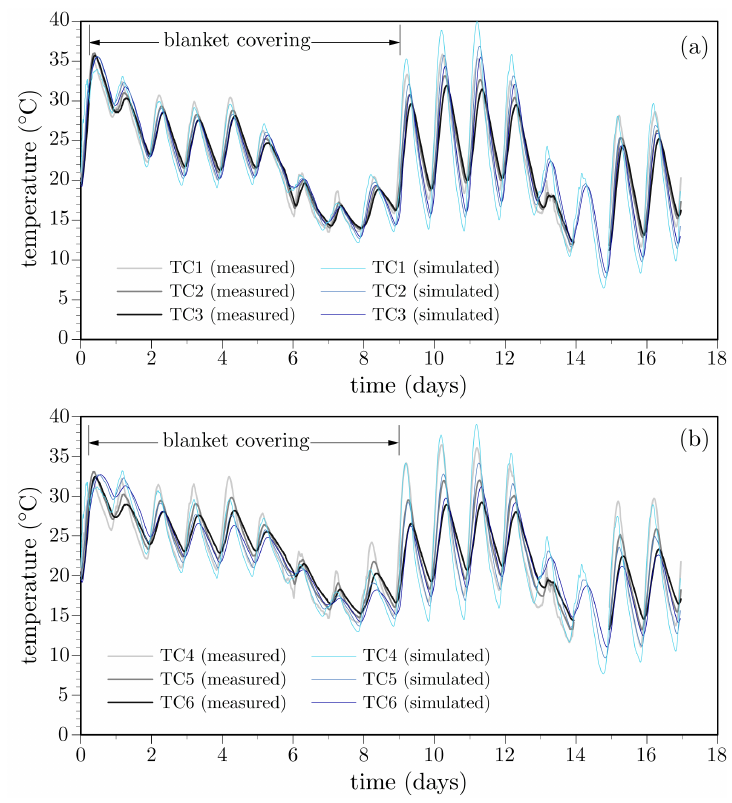
Figure 17. Measured and simulated temperatures at thermocouple